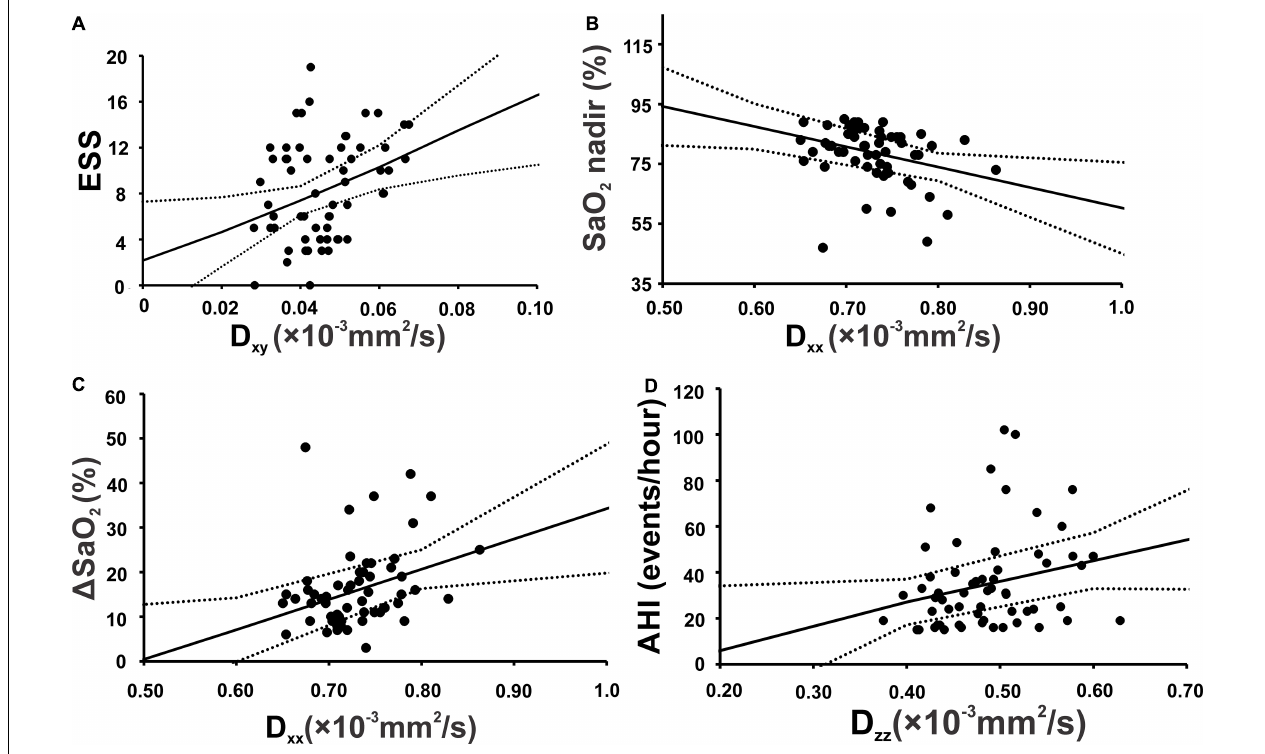
FIGURE 4 | Scatterplots show significant correlation in projection fiber area between Epworth sleepiness scale and diffusivity along the x - y axis (A) , lowest oxygen saturation level of OSA patients (SaO 2 nadir) and diffusivity along the x -axis (B) (cid:49) SaO 2 and diffusivity along the x -axis (C) . Along association fiber area, apnea-hypopnea index showed significant positive correlation with diffusivity along the z -axis (D)